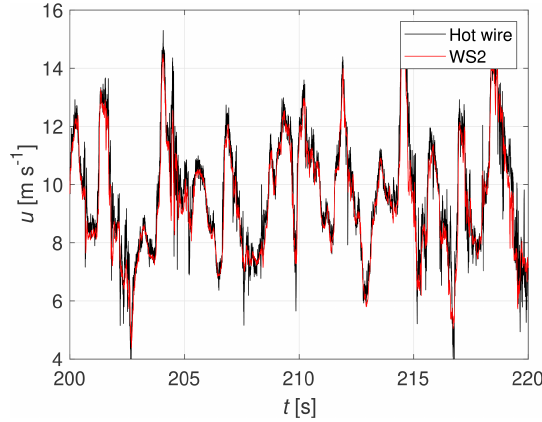
Figure 8. Snapshot of the 10min time series measured by Wind- Scanner 2 and the hot-wire anemometer for a turbulence intensity of 22% (Case